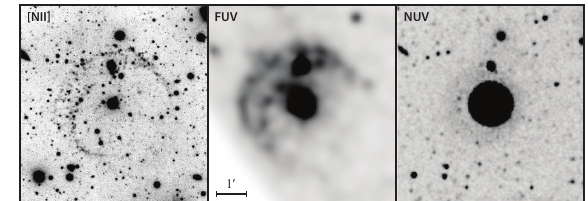
Figure 6: Three images of the classical nova shell sur- rounding the current dwarf nova AT Cancri; from left to right they are in [NII] from the KPNO 4m telescope, Far-UV (1516 ˚A) and Near-UV (2267 ˚A) from